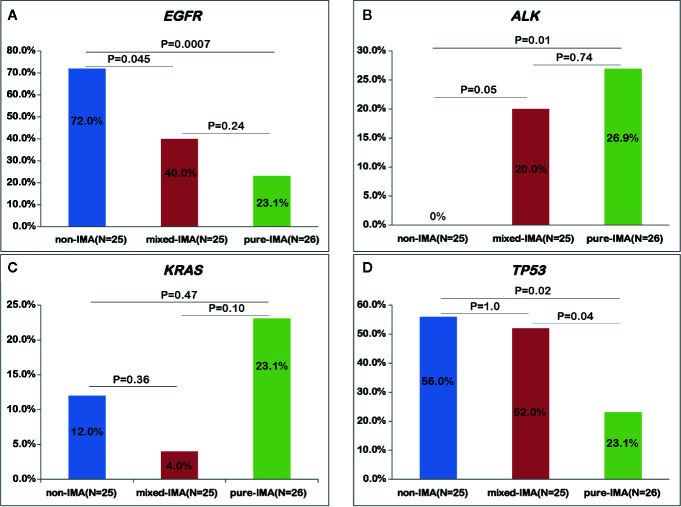
Comparing the alterations of common driver and suppressor genes among samples with different mucinous contents. The mutational frequency of EGFR mutation (A), ALK fusion (B), KRAS mutation (C), and TP53 mutation (D) was compared in patients with non-IMA, mixed-IMA and pure-IMA.